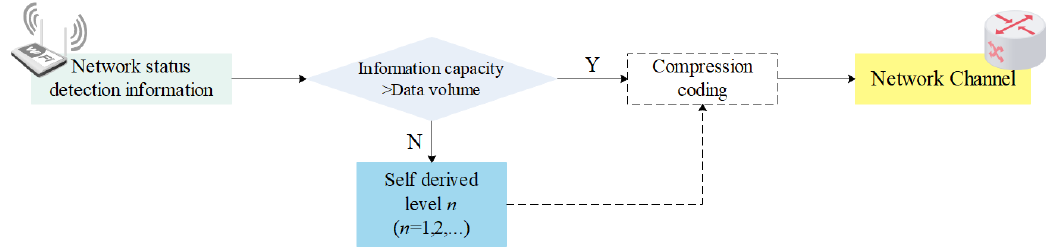
Figure 2. Flow chart of self-derived characteristics.